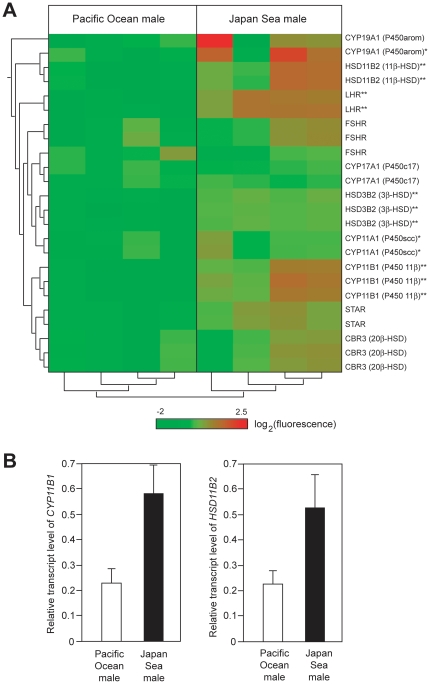
Divergence in the expression levels of steroidogenic enzymes between the gonads of Pacific Ocean and Japan Sea forms.(A) Microarray analysis of testis. Heat map and clustering analysis of the transcripts of genes encoding steroidogenic pathways are shown. Different lines represent different probes. For most genes, multiple independent probes were designed for the same gene. Cluster analysis of probes (shown on the left side of the heat map) indicates that signals of different probes representing the same gene product gave rise to similar signals. Different columns indicate different fish (n = 4 males for each form). In the heat map, red colors indicate high fluorescence signals, while green colors indicate low fluorescence signals. Asterisks indicate that the fluorescence signals that were significantly higher in the Japan Sea males than in the Pacific Ocean males by ANOVA; *, P<0.05; **, False Discovery Rate-corrected P<0.05. (B) qPCR analysis of the transcripts of genes encoding two enzymes involved in the conversion of testosterone into 11-ketotestosterone, 11β-hydroxylase (CYP11B1) and 11β-hydroxysteroid dehydrogenase (HSD11B2) (n = 4 fish for each form).